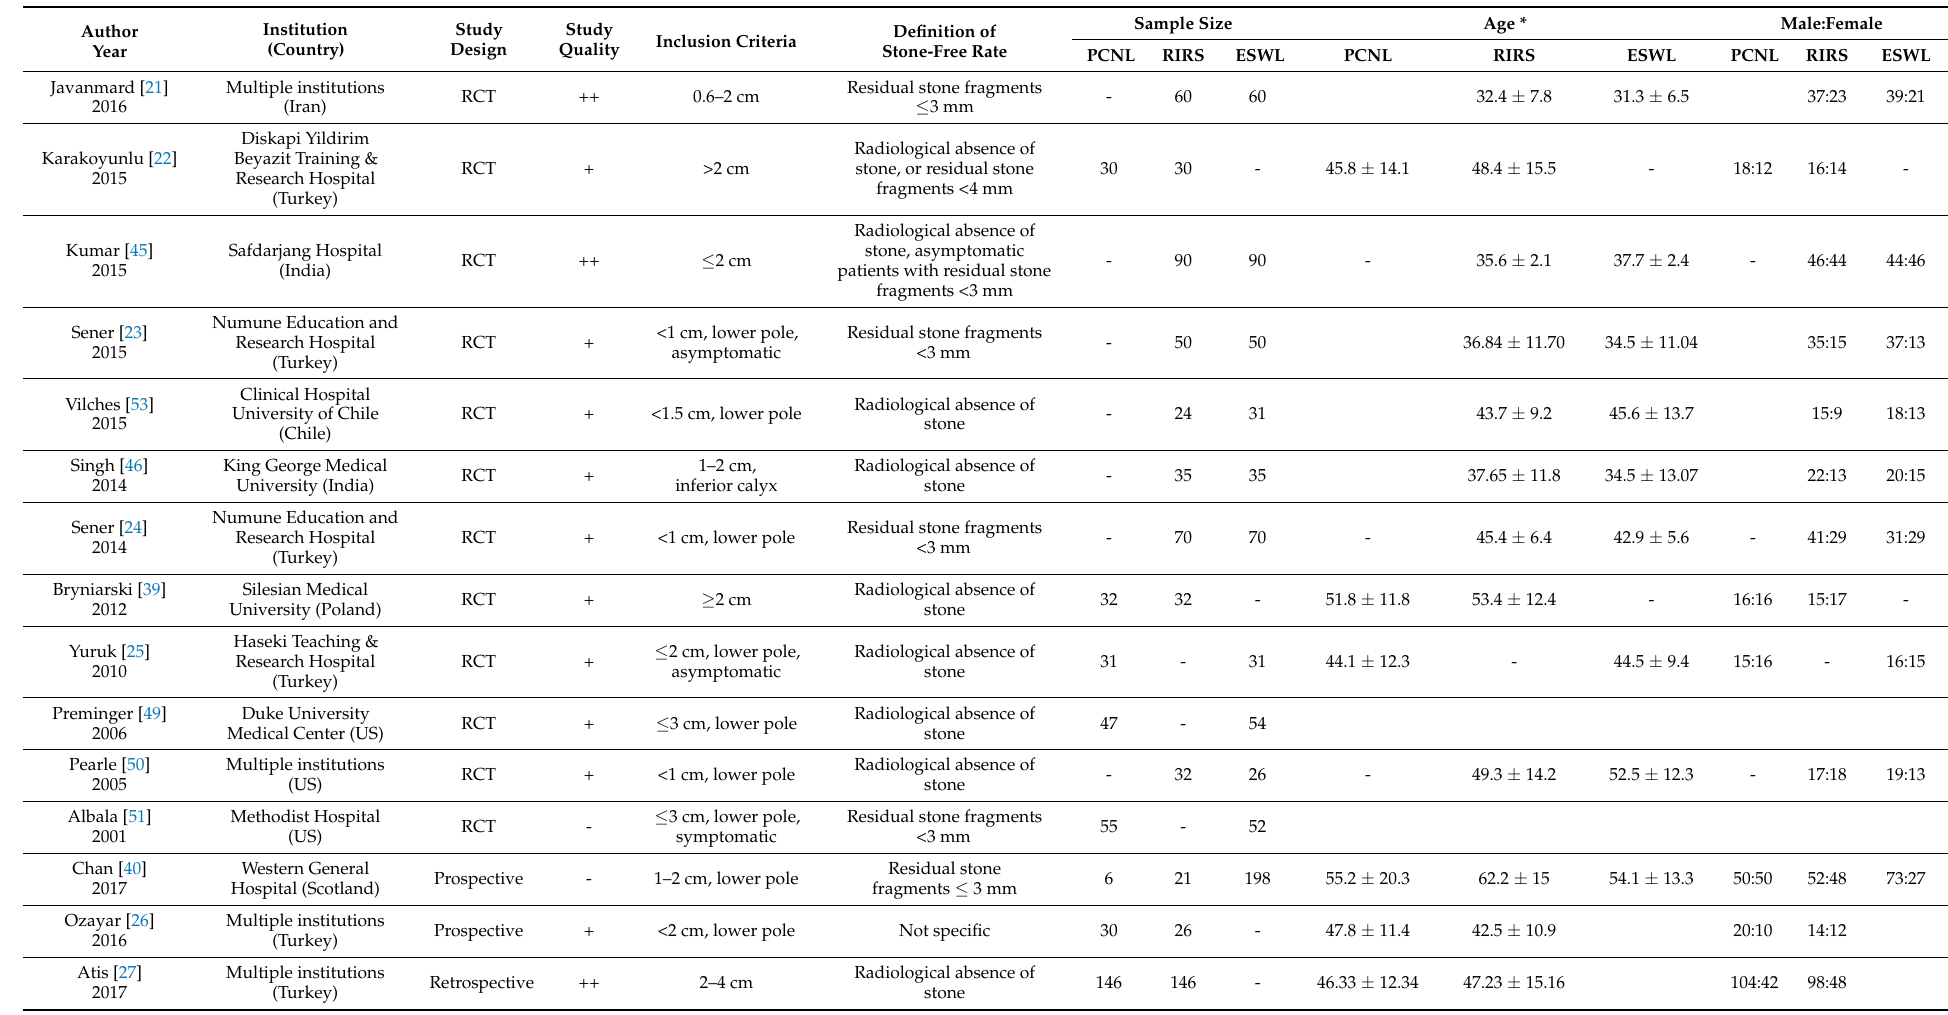
Table 1. Characteristics of included